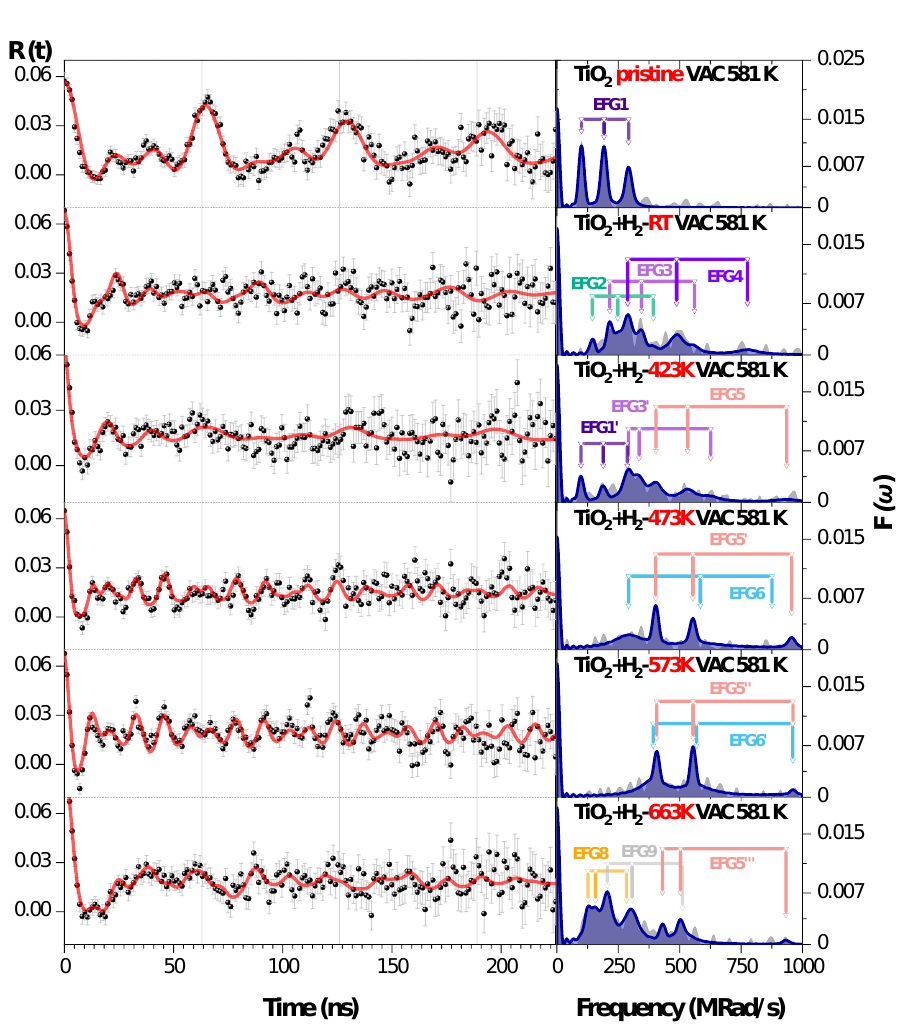
Figure 1. PAC spectra as a function of hydrogenation temperature with the corresponding Fourier transforms. Solid lines are the least-squares fit of the appropriate theoretical function to the experi- mental